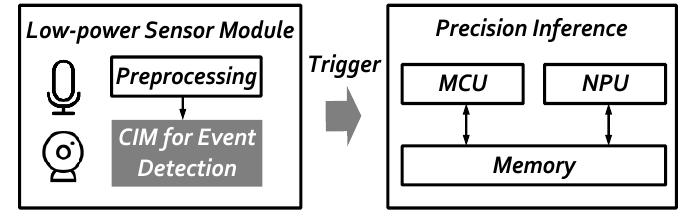
Figure 1. Hierarchical AI